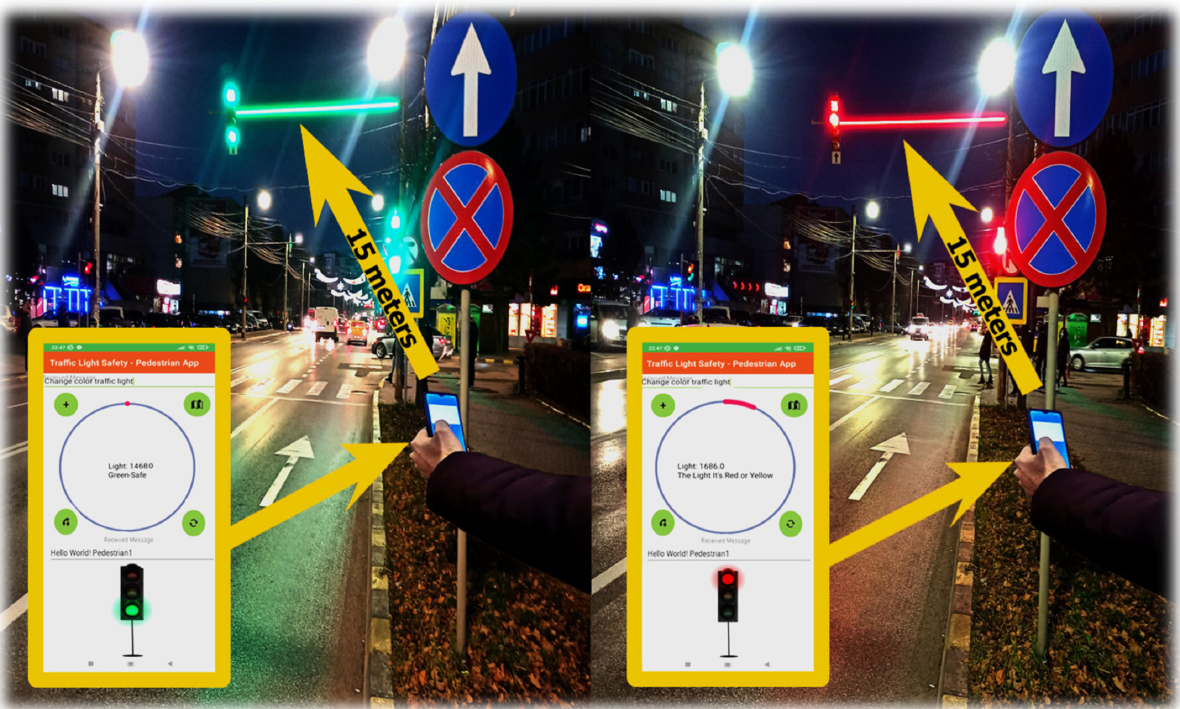
Figure 16. Exposure of the application in a dynamic environment, making measurements over a maximum distance of 15 m.